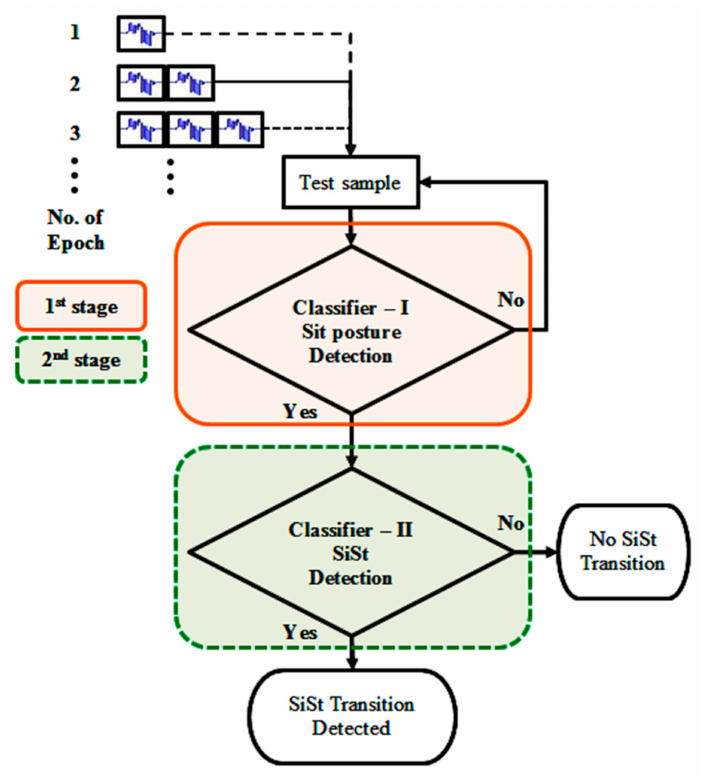
Figure 3. Flow diagram of the proposed two stage postural transition